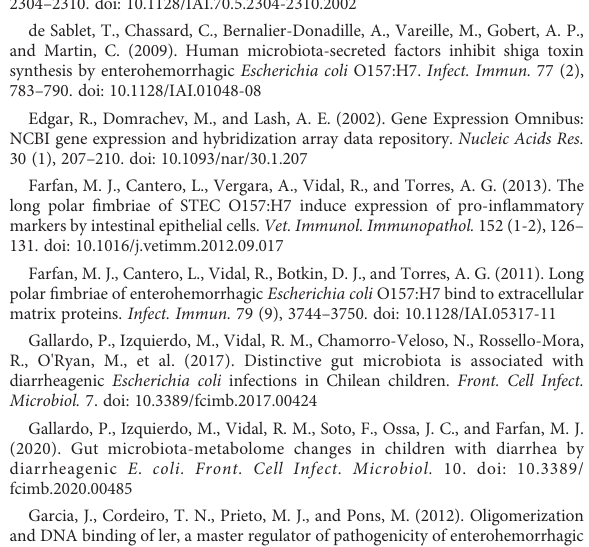
SUPPLEMENTARY FIGURE 1 Changes in gene expression for DEC pathotypes incubated with EA or CW SP. Reference strains of STEC (A, C) and EAEC (B, D) were incubated with M9 medium (control) or supernatant from EA (A, B) or CW (C, D) . RNA extraction and analysis by RNA-seq was performed. Changes in gene expression, compared to the control condition, were colored according to the change observed; genes upregulated are in blue, genes downregulated are in red, and genes with no change compared to the control are in gray.